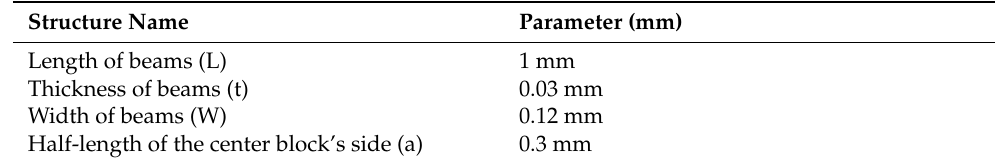
Figure 3. Schematic diagram of the main process flow of the sensor micro-structure. Table 1. Parameters for sensitive structures.